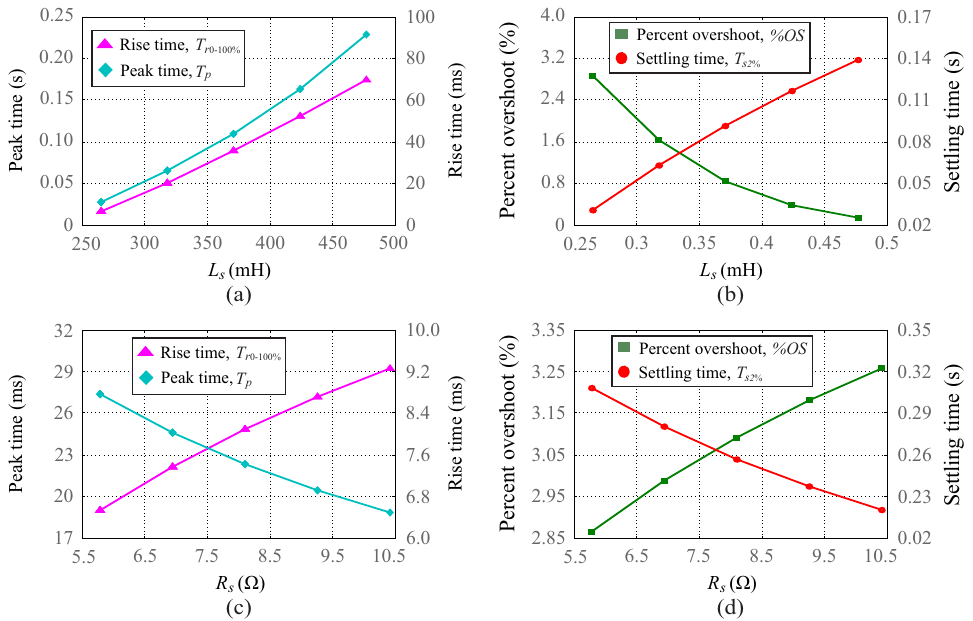
Figure 5. Flux transient response specifications for armature winding parameter variations. ( a ) Rise time and peak time for L s variations. ( b ) Percent overshoot and settling time for L s variations. ( c ) Rise time and peak time for R s variations ( d ) Percent overshoot and settling time for R s